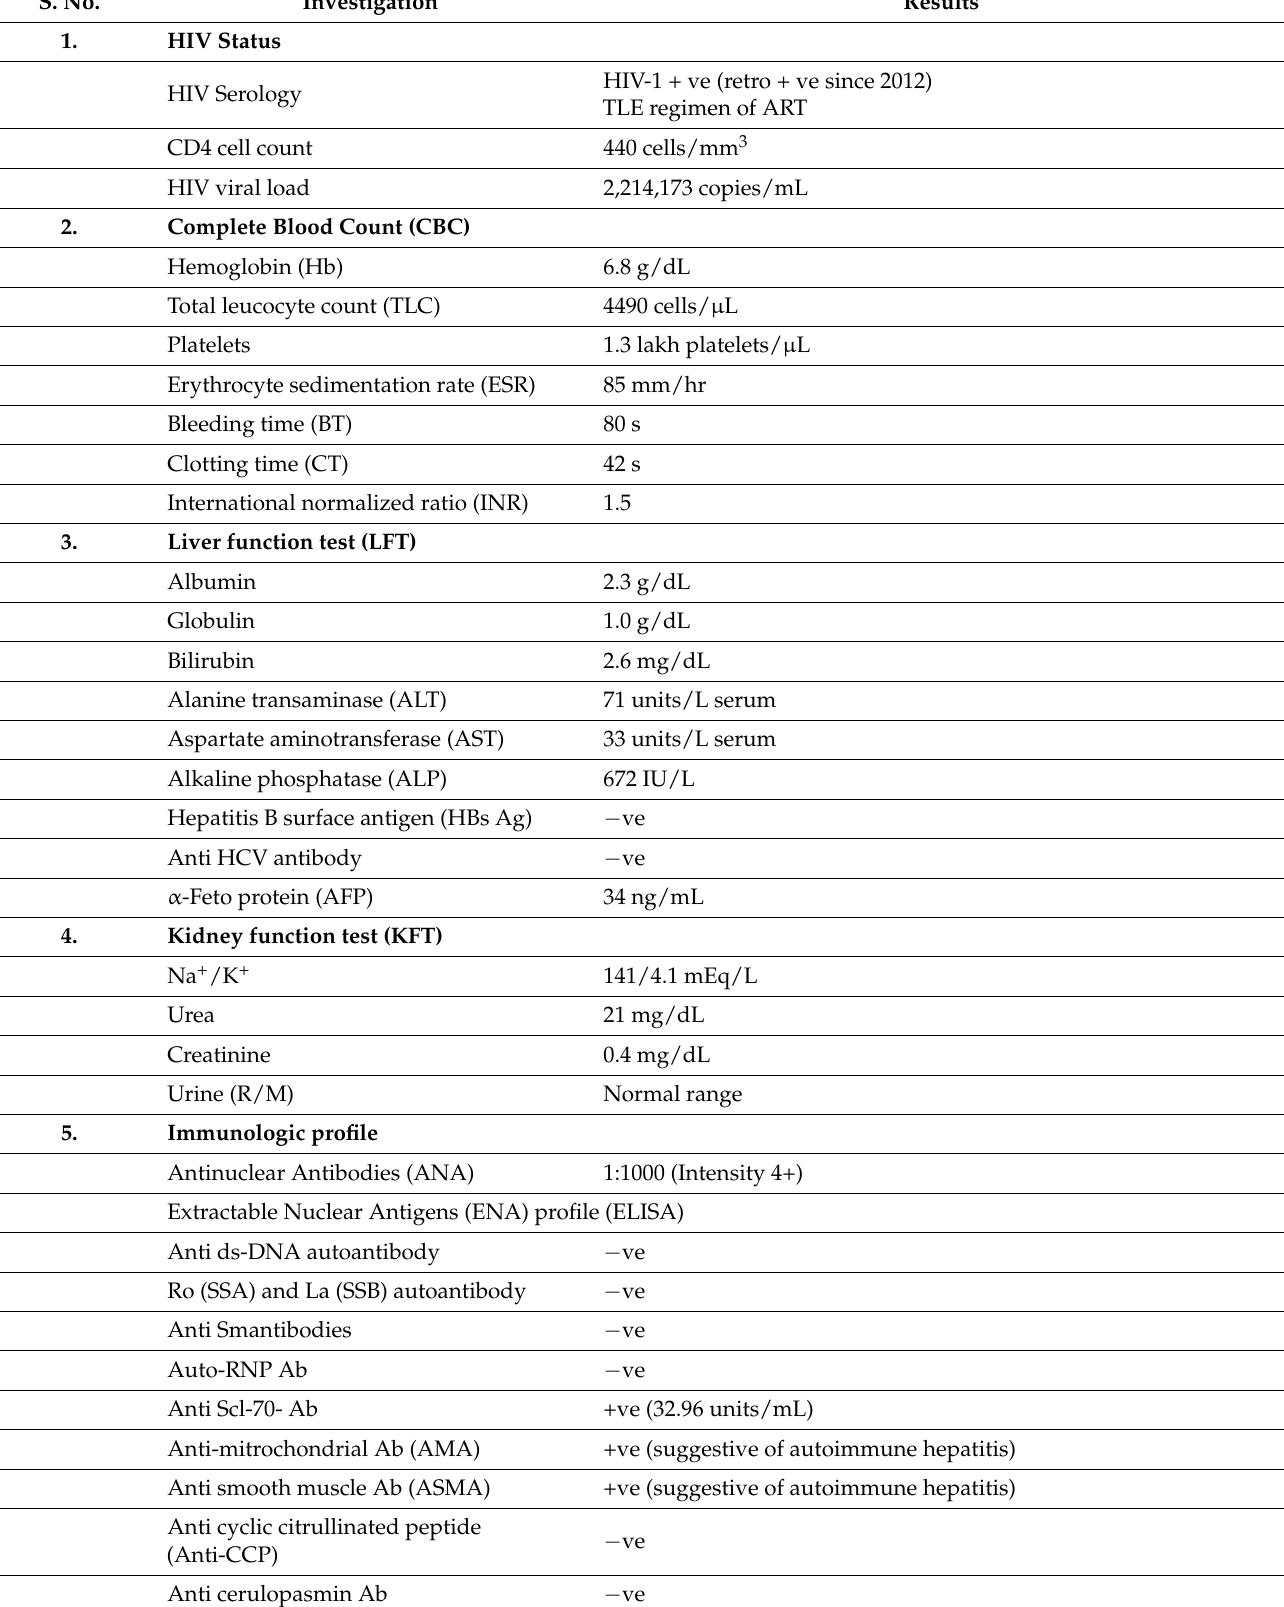
Table 1. Summary of investigations and treatment